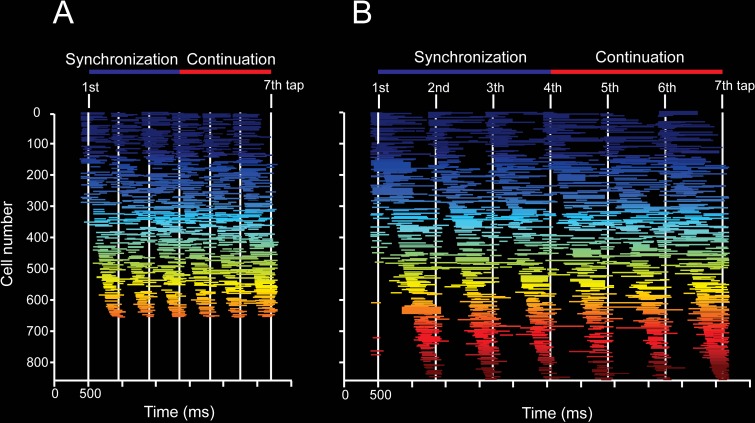
Overall patterns of activity in cell populations.A,B. Neural activation periods, sorted by their mean peak activation time, during the SCT task for the target intervals of 450 (A) and 850 (B) ms. Each horizontal line corresponds to the onset and duration of the significant activation period of a cell according to the Poisson-train analysis (see Materials and methods). The Poisson-train analysis was carried out on the discharge rate of cells that was warped in relation to the tapping times (seven white vertical lines [4,73]). Note that the number of cells with significant activation periods is larger for the longer target interval. Underlying data are available in https://doid.gin.g-node.org/d315b3db0cee15869b3d9ed164f88cfa/. SCT, synchronization-continuation task.